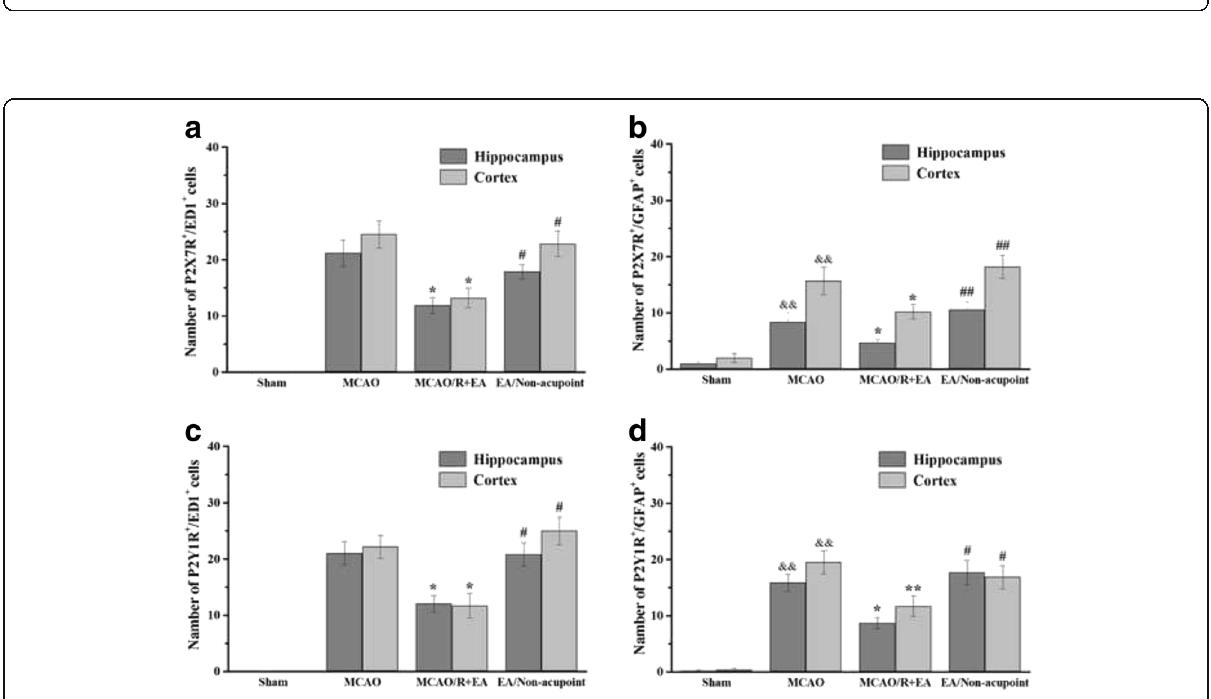
Fig. 10 Quantification of co-expression in peri-infarct hippocampal CA1and sensorimotor cortex. Quantification of P2X7R and ED1( a ), P2X7R and GFAP( b ), P2Y1R and ED1 ( c ) and P2Y1R and GFAP ( d ) co-expression showed lower density in the MCAO/R + EA group compared to the MCAO/R group and the MCAO/R+ Non-EA group in peri-infarct sensorimotor cortex. Quantification of P2X7R and ED, P2Y1R and ED1 and P2Y1R and GFAP co-expression showed lower density in the MCAO/R + EA group compared to the MCAO/R group and the MCAO/R+ Non-EA group in peri-infarct hippocampal CA1. Data are shown as mean ± S.E.M from 6 individual rats in each group. && P < 0.01, the MCAO/R group versus the Sham group; ** P < 0.01, * P < 0.05, the MCAO/R + EA group versus the MCAO/R group; ## P < 0.01, # P < 0.05, the MCAO/R + EA group versus the MCAO/R+ Non-EA